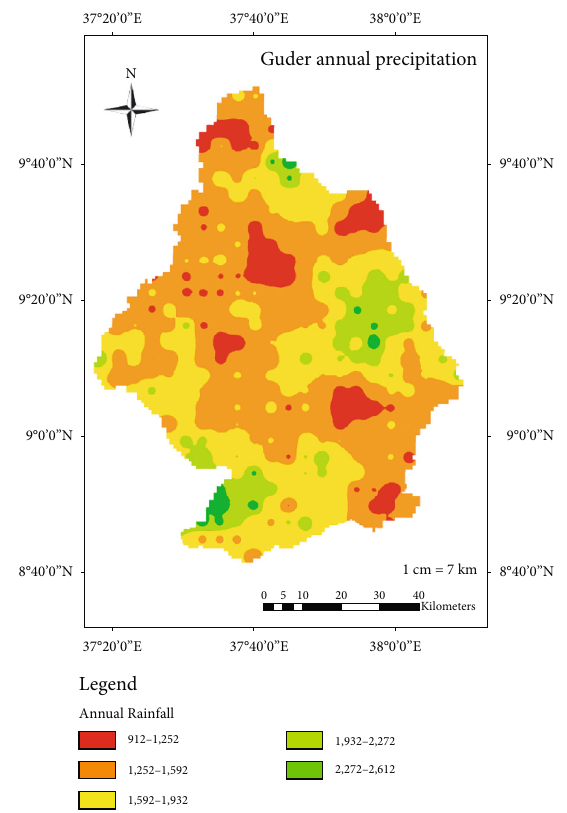
Figure 13: Annual rainfall distribution map of the study